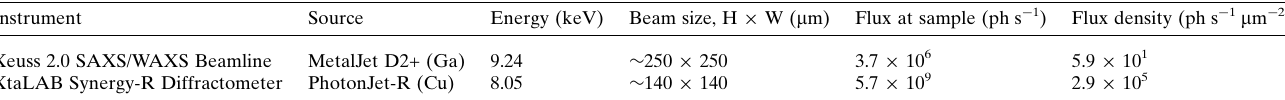
Table 1 X-ray source and beam characteristics. Instrument